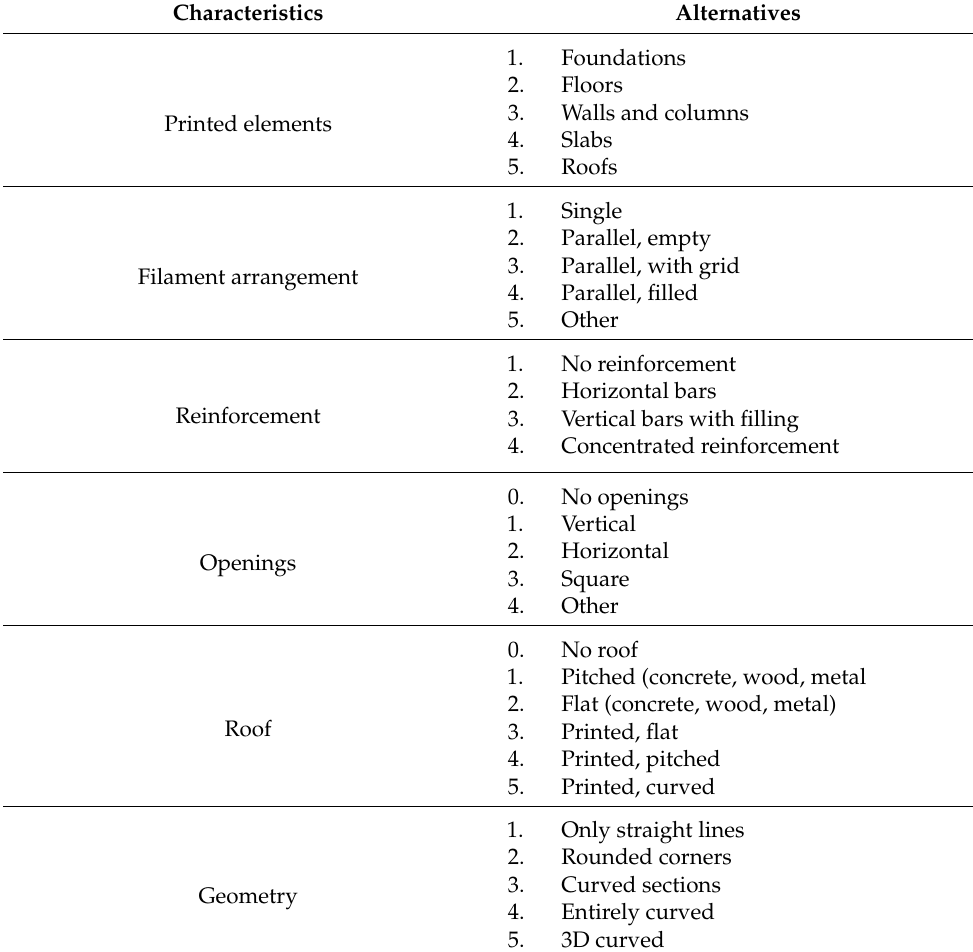
Table 2. Building